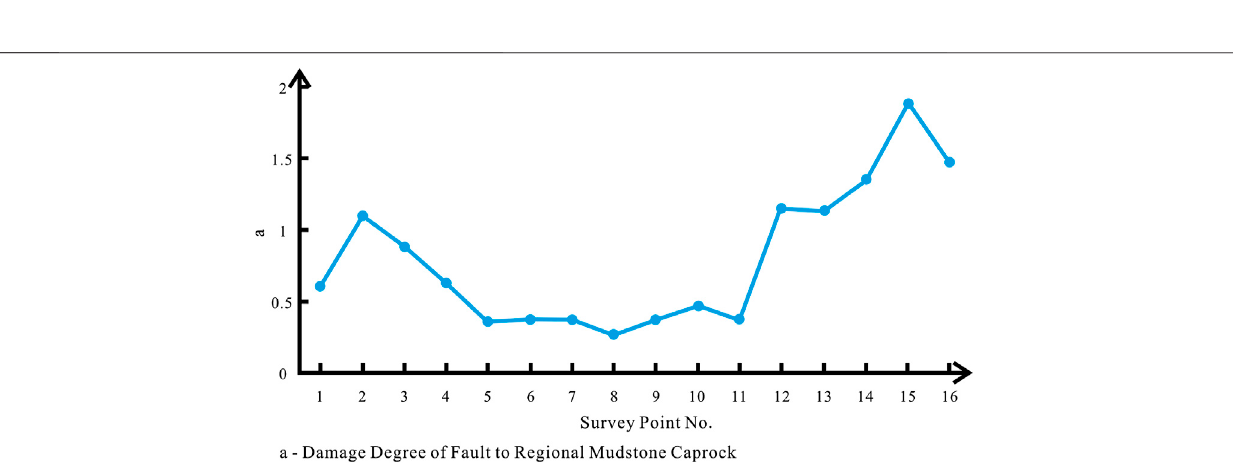
Frontiers in Earth Science |